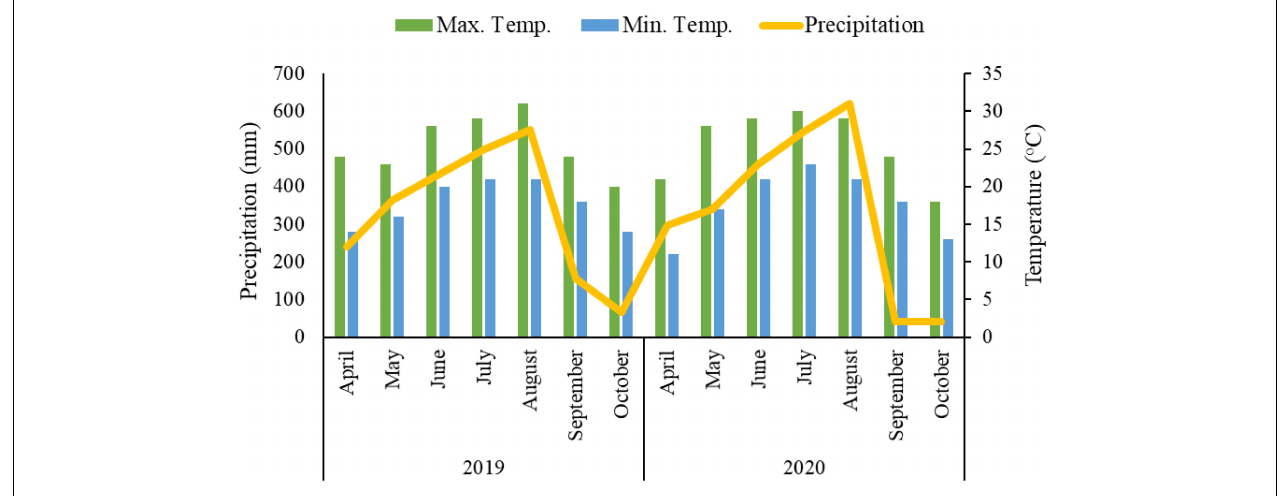
FIGURE 1 | Climatic data showing mean monthly precipitation (mm), maximum and minimum temperature ( ◦ C) of growing seasons